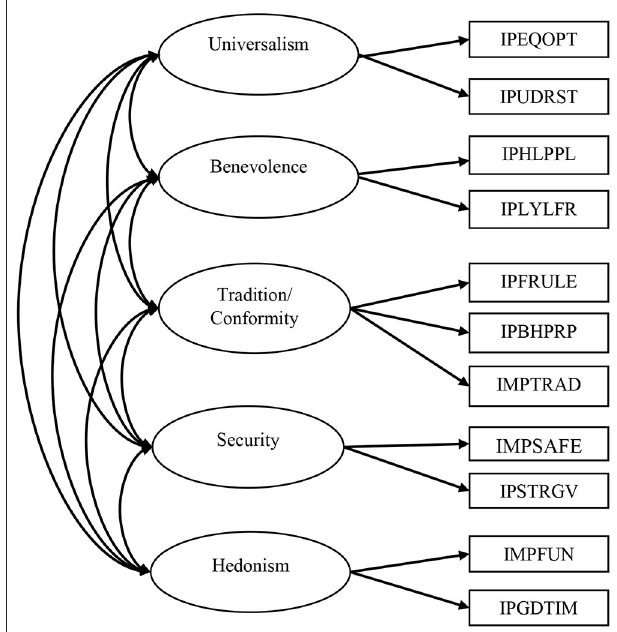
FIGURE 2 | Multi-group confirmatory factor